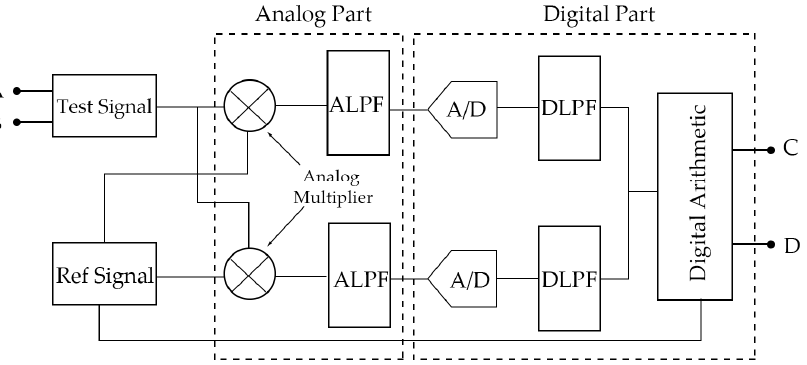
Figure 5. Schematic diagram of a lock-in amplifier with a digital–analog hybrid structure.